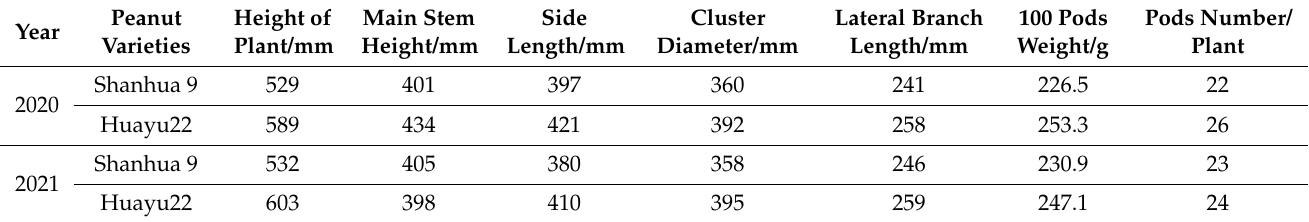
Table 1. Initial characteristics of peanut plants after excavation.